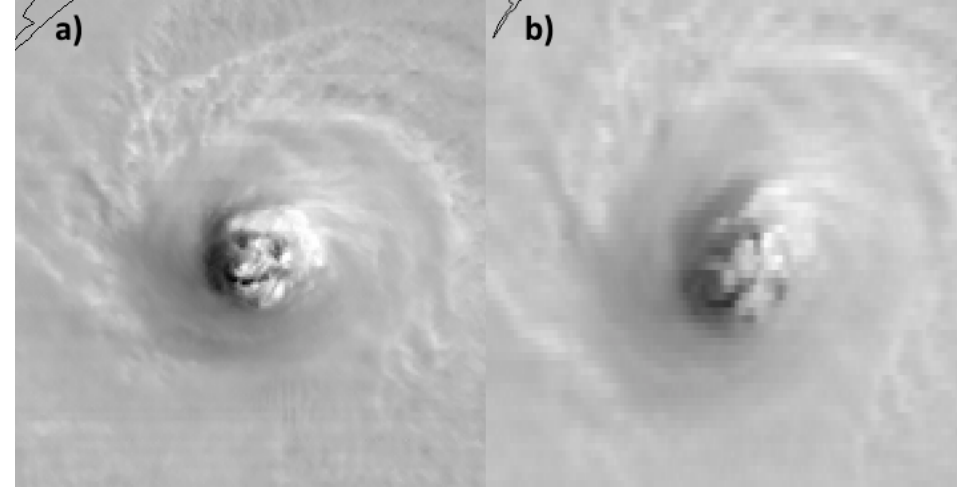
Figure 19. A comparison of the eye of Hurricane Harvey from 25 August 2017 at 2015 UTC as it approached the Texas coast from: ( a ) GOES-16 band 2; and ( b ) GOES-13 band 1.